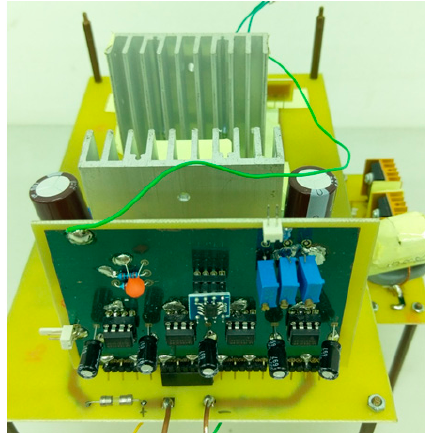
Figure 6. Photograph of the proposed prototype.